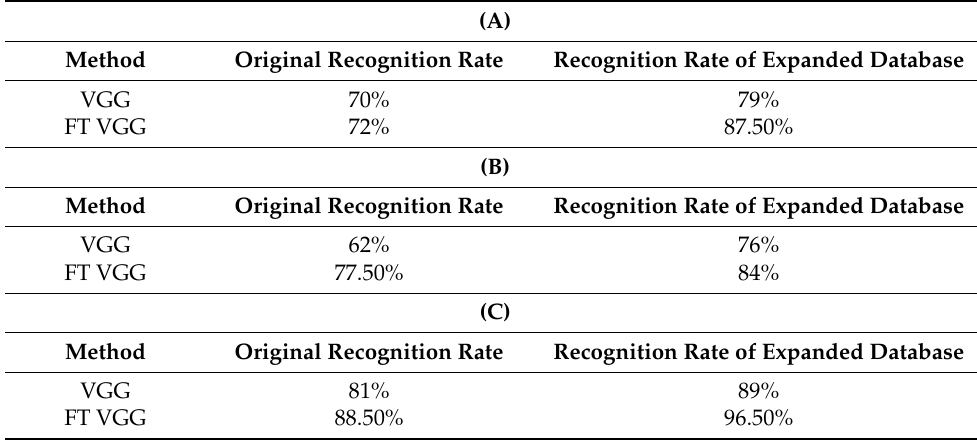
Table 3. ( A ) Identification rate of cabbage. ( B ) Identification rate of lettuce. ( C ) Identification rate of Pleurotus eryngii .